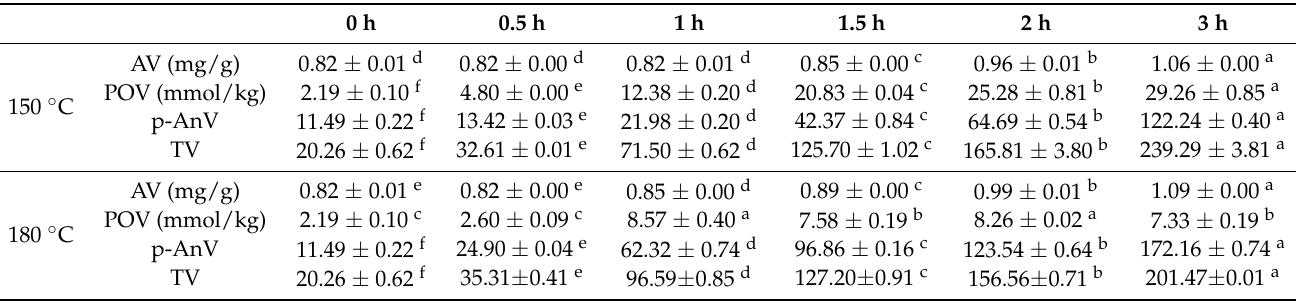
Table 3. Changes in AV, POV, p-AnV and TV of SFO&SSO oil blend during heating.